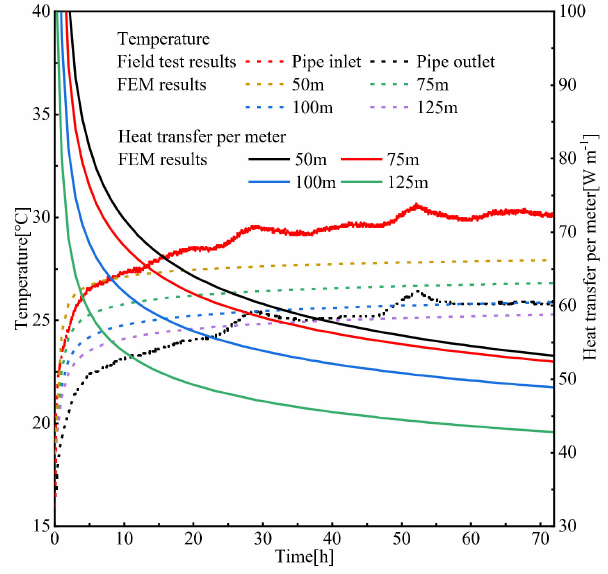
Figure 8. The variation curve of outlet temperature and unit heat exchange of #2 pile under different well depth conditions (5.5 kW).